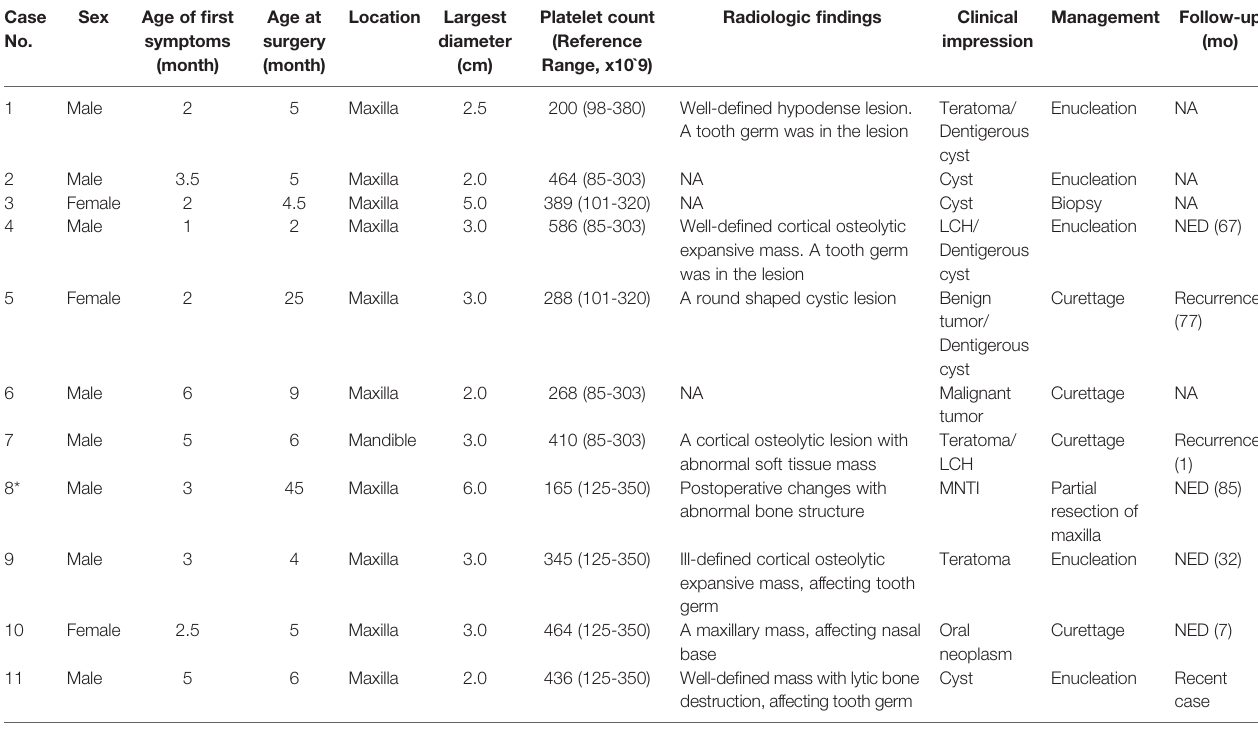
TABLE 2 | Detailed information for all the antibodies used in this study. Antibody Clone Dilution Manufacturer